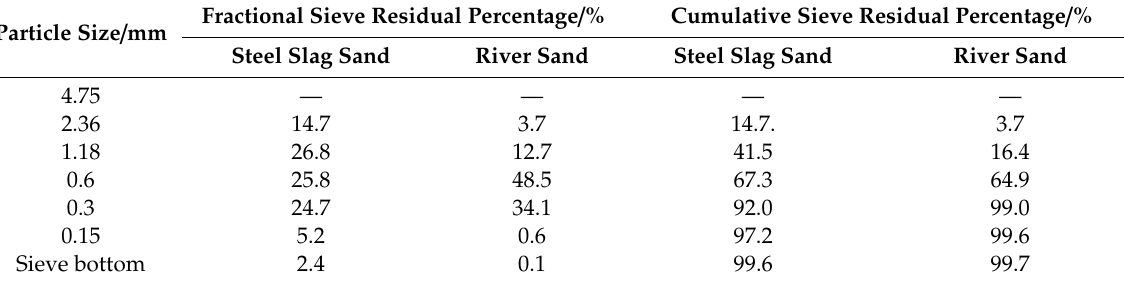
Table 5. Screening of steel slag sand and river